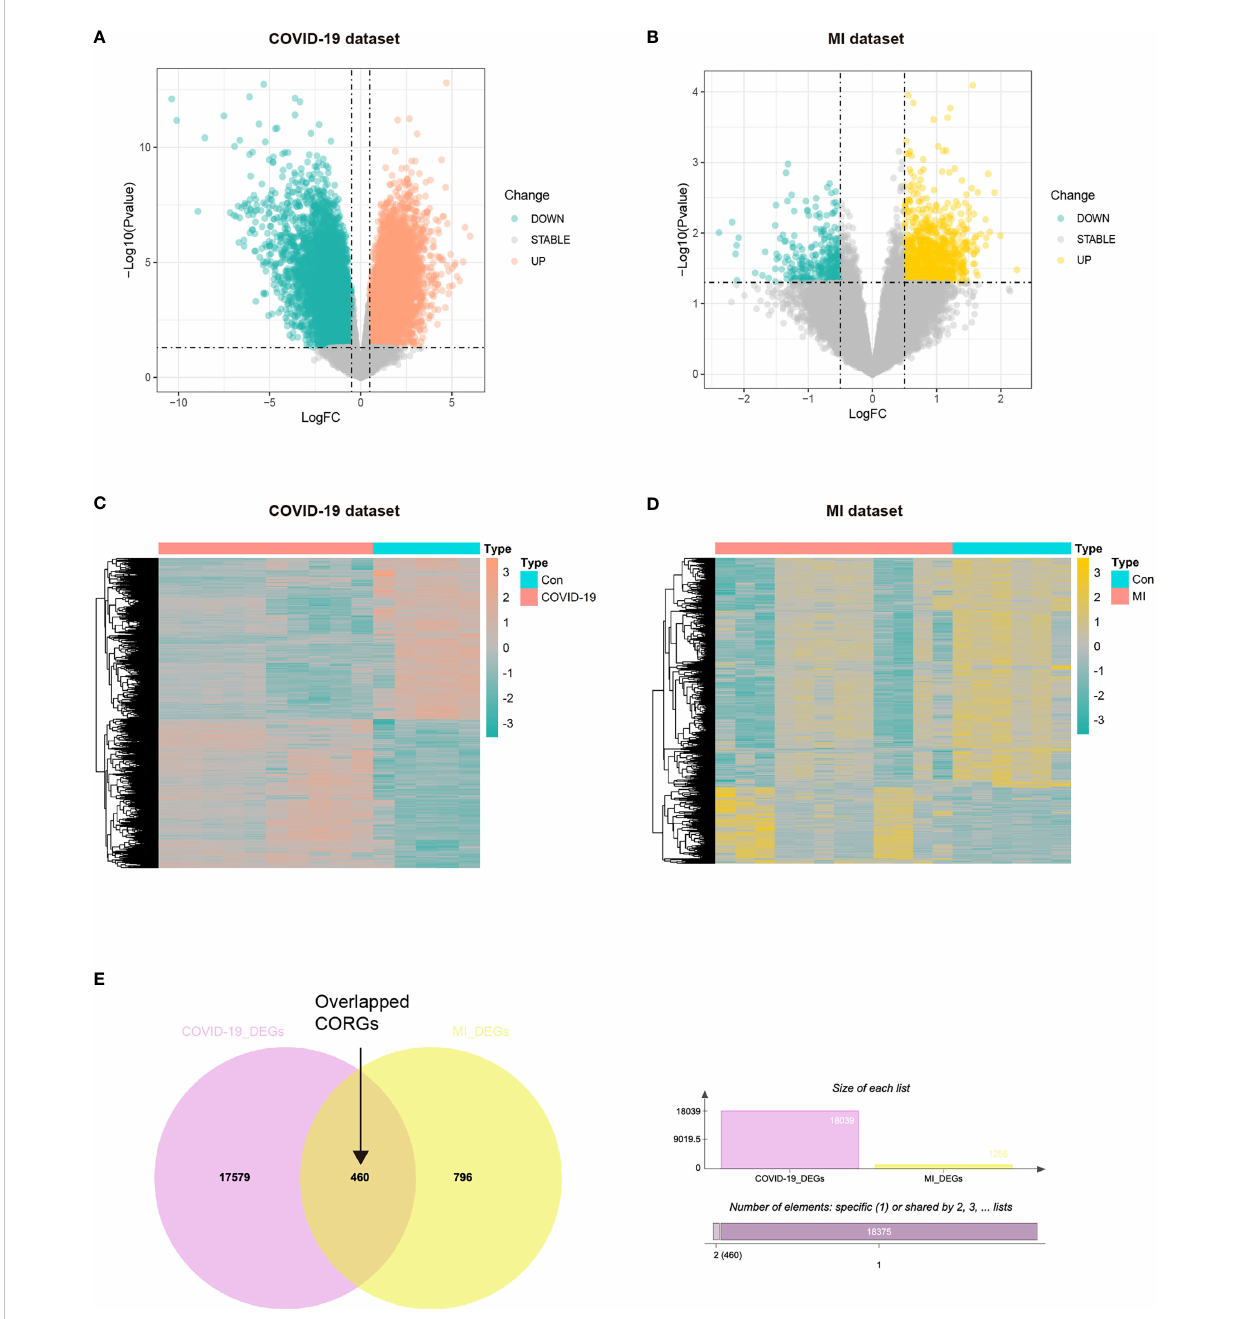
FIGURE 2 Acquisition of overlapped CORGs in the COVID-19 dataset (GSE164805) and MI dataset (GSE160749). (A) DEGs in the COVID-19 and control groups were shown in the Volcano plot, green represents downregulation, grey represents stability, and orange represents upregulation. (B) DEGs in the MI and control groups were shown, green represents downregulation, grey represents stability, and yellow represents upregulation. (C) DEGs were shown in the COVID-19 heatmap. (D) DEGs in the MI heatmap. (E) Venn diagram depicts overlapped CORGs in both the COVID-19 DEGs and MI DEGs. MI, male infertility; GSE, GEO Series; CORGs, COVID-19-related differentially expressed genes; DEGs, differentially expressed